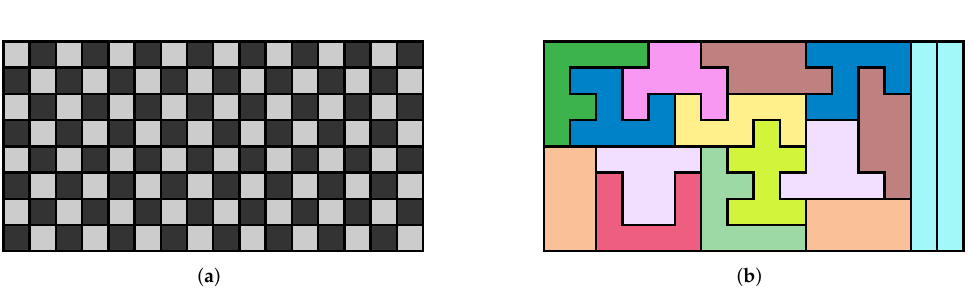
is coloured dark green to distinguish it 9